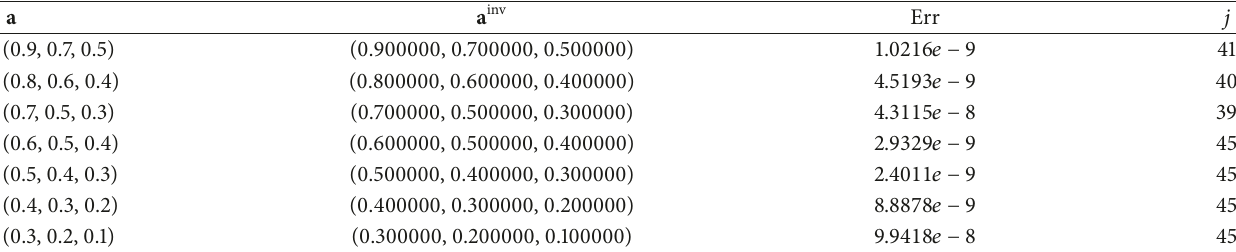
Table 4: The inversion results with different fractional orders for 𝑆 = 2 .